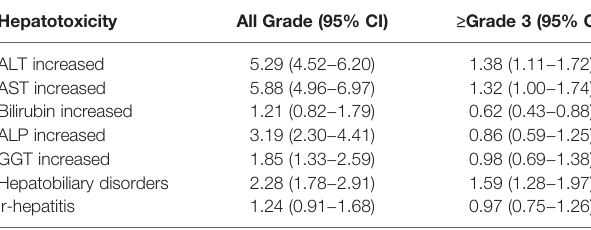
TABLE 1 | Incidence of all grade and ≥ grade 3 hepatotoxicity with ICIs (anti-PD-1/PD-L1). Hepatotoxicity